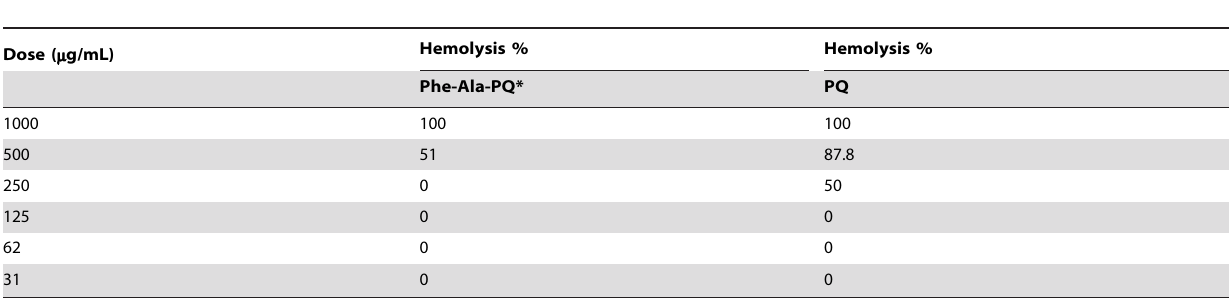
Table 3. Percentage of in vitro hemolysis by Phe-Ala-PQ and PQ in G6PD-deficient human red blood cells.